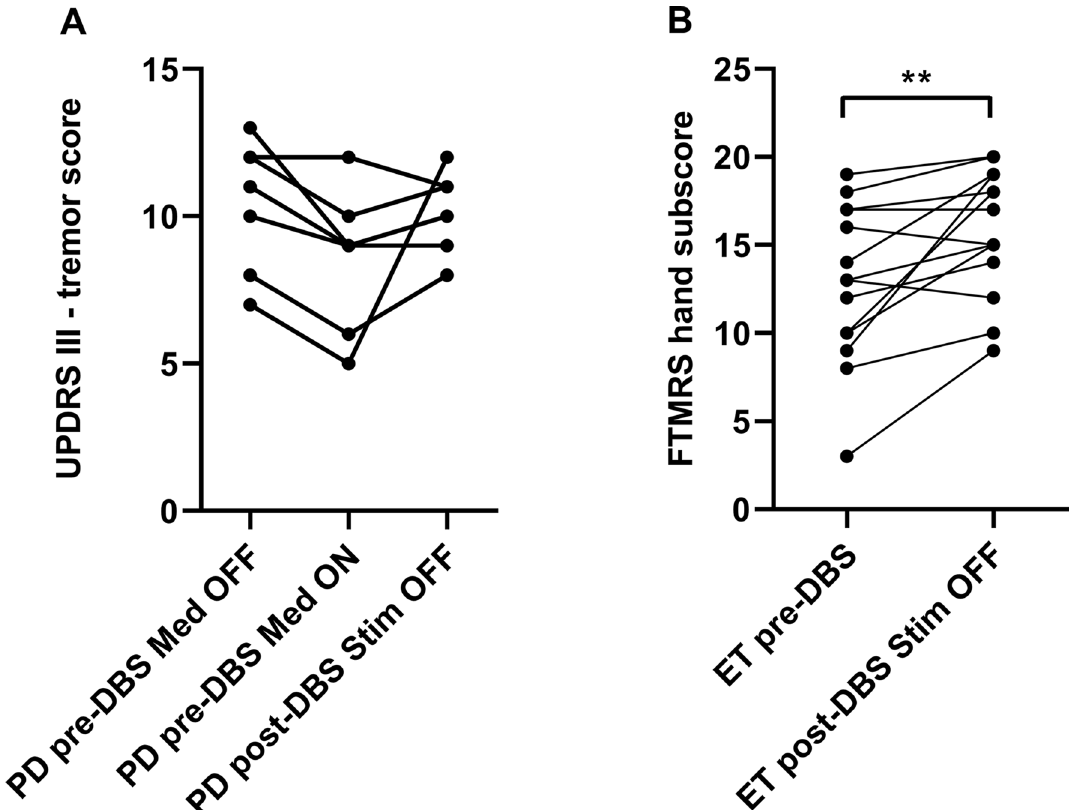
Figure 2. Tremor scores pre- and postoperatively without DBS. ( A ) Parkinsonian (PD) patients were assessed by the tremor items of the UPDRS preoperatively in Med OFF and Med ON condition as well as postoperatively in Med ON STIM OFF. ( B ) Essential tremor (ET) patients were assessed pre- and postoperatively in Med OFF condition by the FTMRS. In STIM OFF, PD tremor remained stable, whereas the tremor intensity in ET worsened during the postoperative course indicating natural disease progression. **Significance level of p < 0.01. Figure was created with GraphPad Prism (version 9 for Windows, La Jolla, Conventional and new stimulation modes of VIM/PSA‑DBS in PD patients. In PD patients, new stimulation forms as short pulse stimulation and directional stimulation were compared to conventional omni- directional 60 µs VIM/PSA-DBS. The use of short pulse stimulation was equivalent in suppressing tremor compared to conventional VIM/ PSA-DBS, but with less side effects at the ventral and adjacent dorsal contact. GLM ANOVA with the factor stimulation mode (3 levels: 1. STIM OFF 2. oDBS60 3. oDBS30) revealed significant effects for the tremor hand subscore (ventral contact: F = 36.66, p = 0.001; dorsal contact: F = 29.29, p = 0.004) and ataxia (ventral contact: F = 36.86, p < 0.001, dorsal contact: F = 15.65, p = 0.002). Paresthesia was not significantly different during the different STIM conditions. The divergent clinical effects and side effects were most evident at the ventral contact, but also observed at the dorsal contact. The tremor hand subscore was significantly improved by both oDBS60 (ventral 2.14 ± 0.9; p = 0.001, dorsal 3.0 ± 0.7; p = 0.004) and oDBS30 (ventral 1.71 ± 0.76 p = 0.001, dorsal 2.0 ± 1.22 p = 0.006) com- pared to STIM OFF (12.86 ± 4.6), there was no significant difference between both stimulation modes indicating p < 0.001, dorsal 3.4 ± 1.14 p = 0.003), which was not present in STIM OFF (0.14 ± 0.38). Stimulation-induced ataxia was significantly less accentuated while oDBS30 (ventral 1.43 ± 0.78 p < 0.001, dorsal 1.2 ± 1.3 p = 0.04)